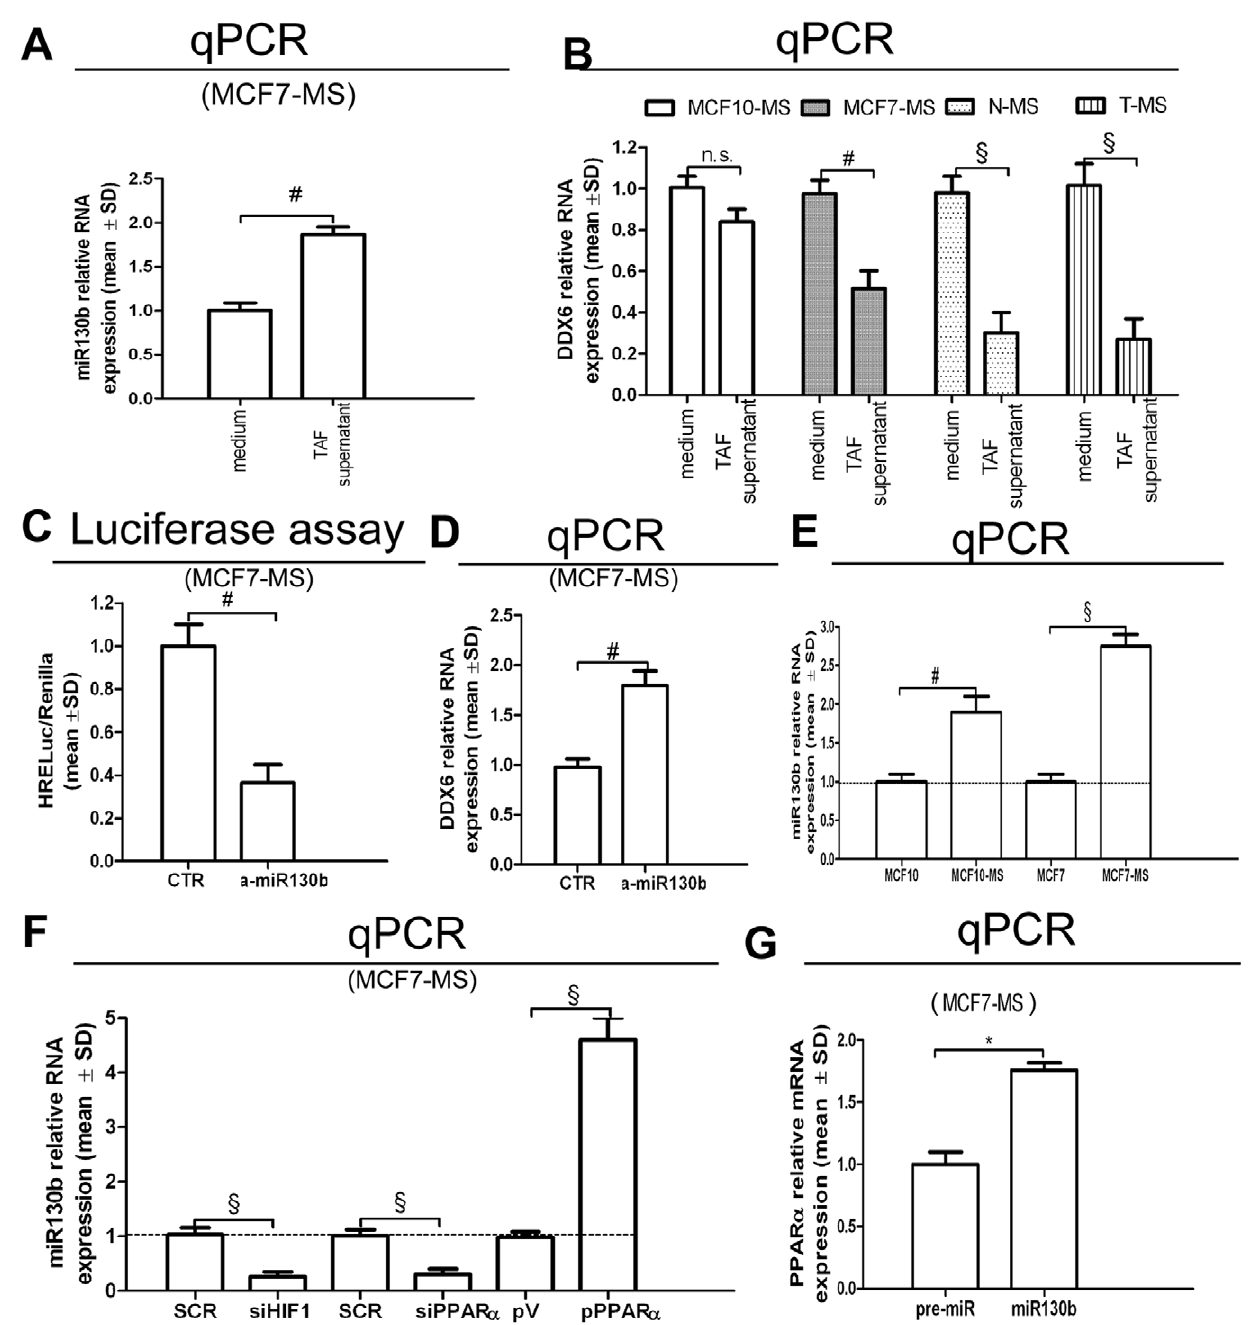
Figure 4. Role of miR130b on the PPAR a /HIF1 a interplay in breast CSCs. (A) miR130b qPCR analysis in TAF supernatant (10%, 24 h)-exposed MCF7-MS; (B) DDX6 qPCR analysis in TAF supernatant (10%, 24 h)-exposed MCF10/MCF7-MS and N 2 /T-MS (samples, 14 and 15); HRELuc assay (C) and DDX6 qPCR mRNA analysis (D) in AntagomiR130b (a-miR130b, 48 h)-transfected MCF7-MS; (E) miR130b qPCR analysis in MCF7 and MCF10 cultured as adherent or MS; (F) miR130b qPCR analysis in SCR/siHIF1/siPPAR a (72 h) and pV/pPPAR a vector (24 h)-transfected MCF7-MS; (G) PPAR a qPCR analysis in pre-miR130b (48 h)-transfected MCF7-MS. Data are expressed as mean 6 S.D., n=3, * p , 0.05, # p , 0.01, 1 p , 0.005, ANOVA test. n.s.: not significant.